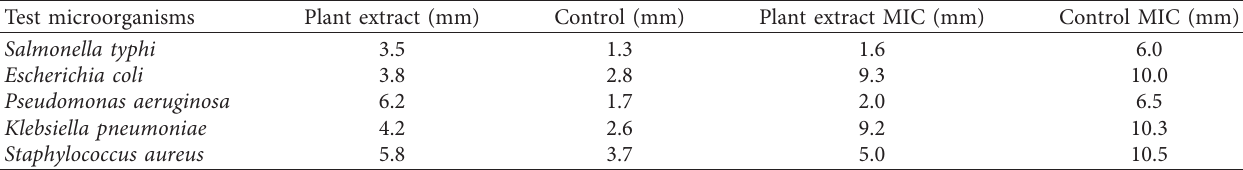
Table 5: Antimicrobial activities of R. raetam plant extract measured by agar well diffusion and MIC methods.